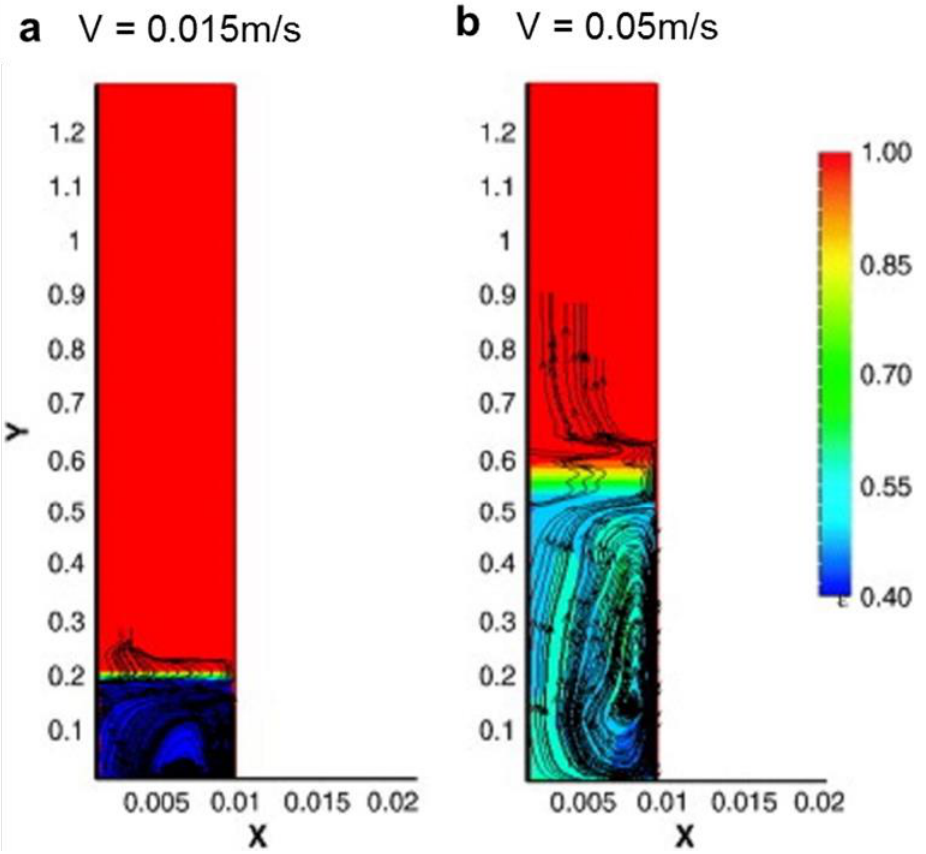
Figure 22. Void fraction distribution in the length of the reactor. The running speed and optimum speed are ( a ) V = 0.015 m/s and ( b ) V = 0.05 m/s [188].